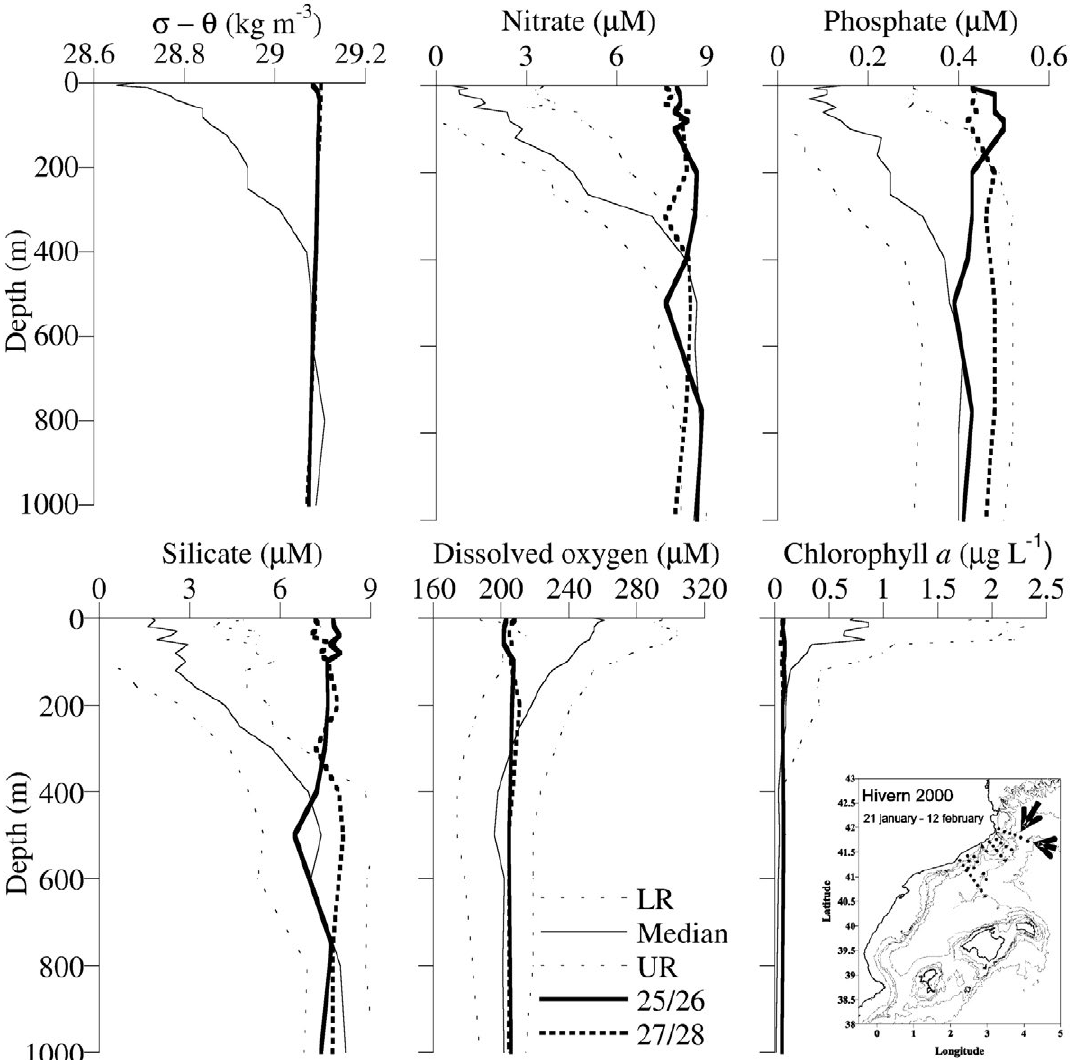
Fig. 8. – Depth profiles of density anomaly, phosphate, nitrate, silicate, dissolved oxygen and chlorophyll a of two stations of the Hivern2000 cruise in the WMDW formation area. The arrows in the inlet map point towards the position of stations 25/26 (41.80°N 3.92°E) and 27/28 (41.73°N 4.11°E). As a reference, the median winter depth profile (Median) of the same variables, and the lower (LW) and upper (UR) ranges of concentration where data are flagged “0” in winter are also